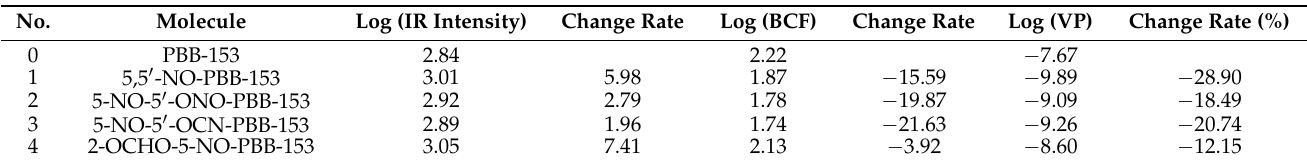
Table 3. The single activity value and change rate of PBB-153 derivatives bioconcentration, long-range transport, and highest infrared signal intensity.